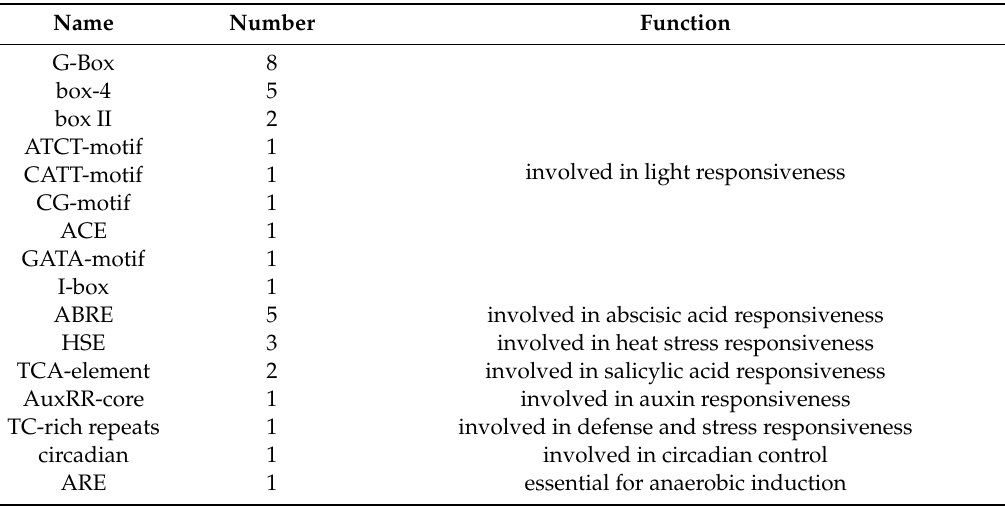
Table 3. Promoter elements of GmRIQ2-like